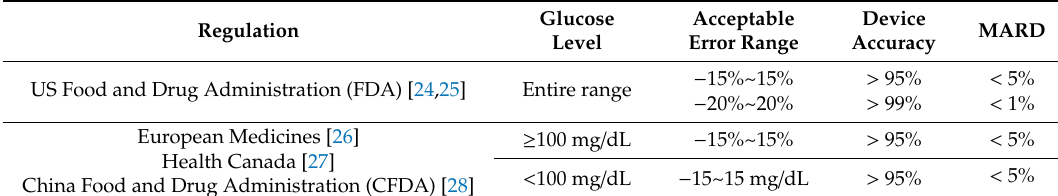
Table 1. Regulations for accurate blood glucose